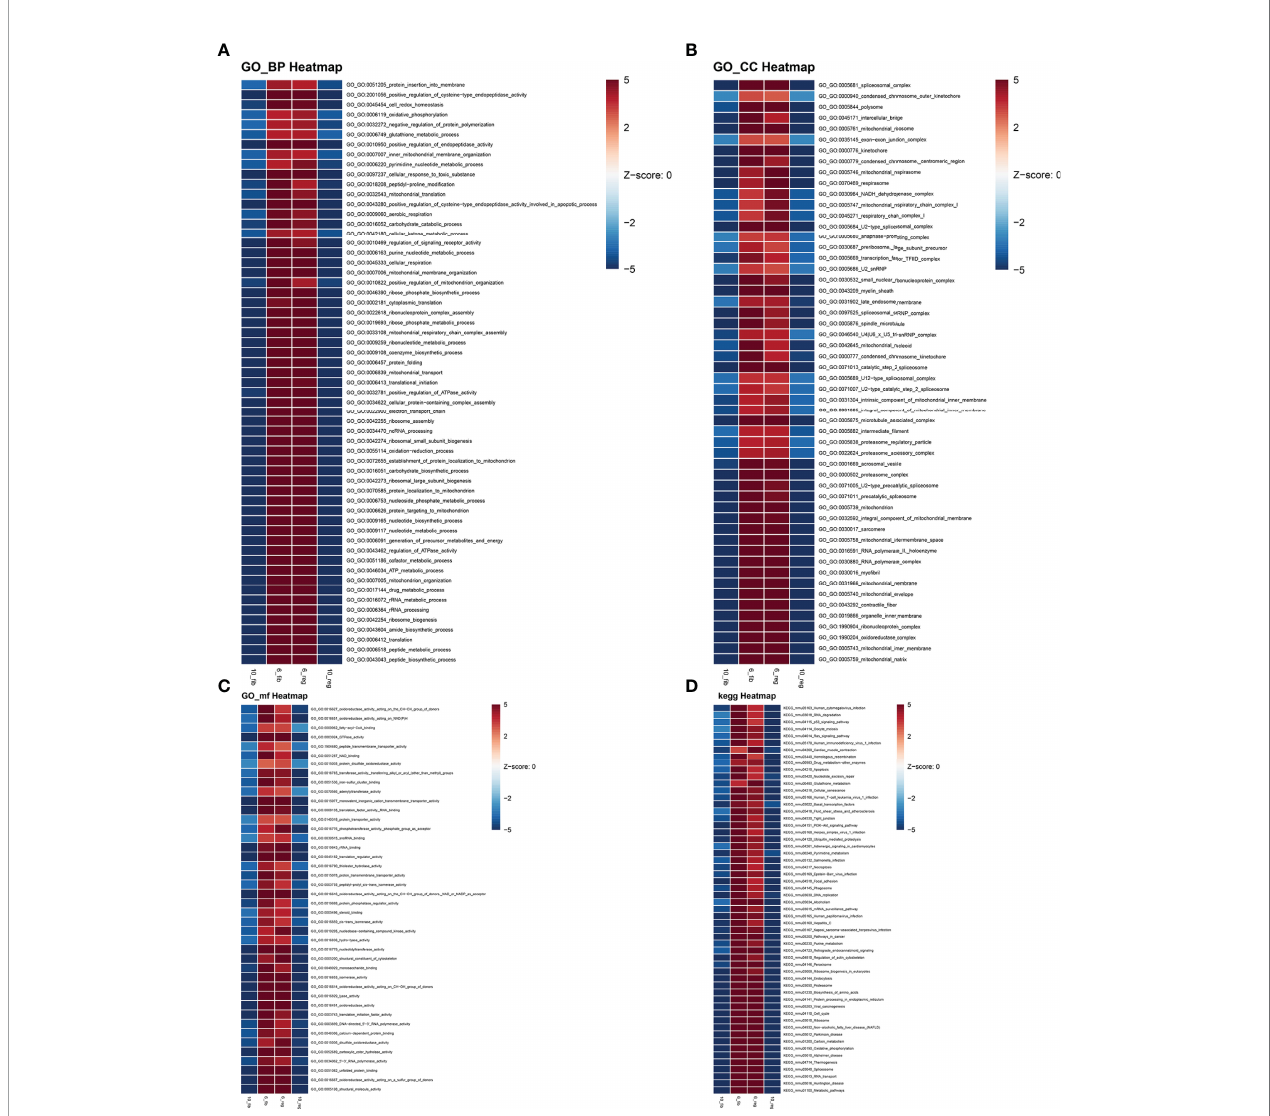
FIGURE 8 | GSVA between clusters 6 and 10 of fi brotic and regenerative myo fi broblasts. (A – D) Heatmaps showing the differences in activation of biological processes, cellular components, molecular functions, and KEGG pathways between clusters 6 and 10 of fi brotic ( fi b) and regenerative (reg) myo fi